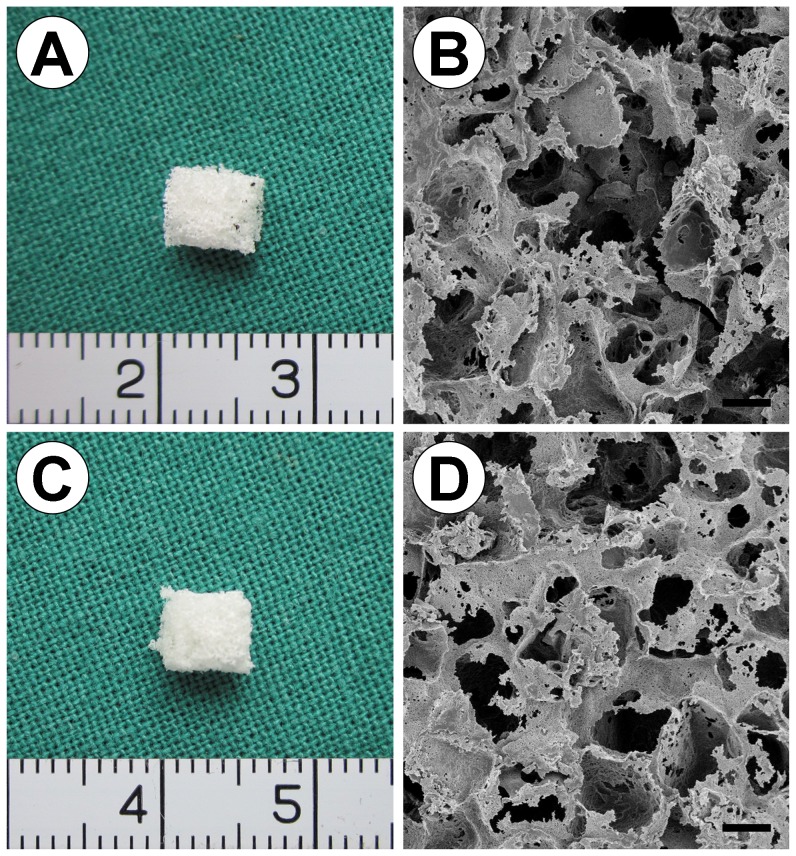
Optical and SEM micrographs of the PHBV and PHBV/BG scaffolds.The PHBV and PHBV/BG scaffolds prepared using the compression molding, thermal processing and salt particulate leaching method had a regular shape, and some pores on the surface of the scaffolds can be observed. The SEM images show that the PHBV and PHBV/BG scaffolds exhibited a macroporous structure with interconnected open pores, and the pore size varied from 30 µm to 300 µm. Scale bar  = 100 µm.